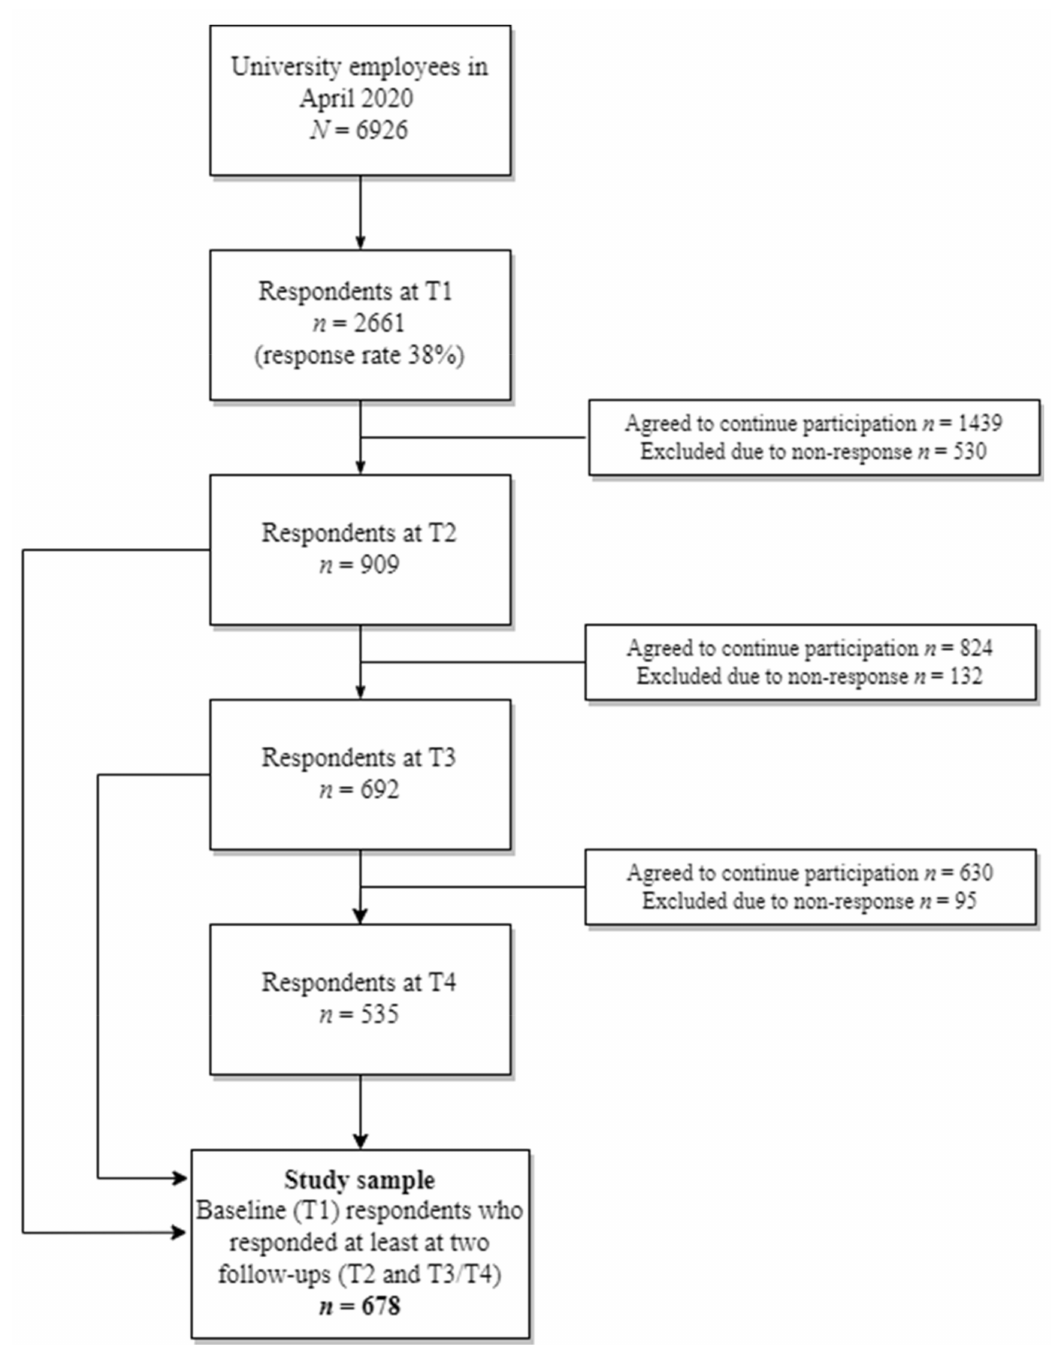
Figure 1. Flowchart of university employees included in the study of work ability profiles during COVID-19 lockdown. T1–T4 are data collection points: T1, April 2020; T2, June 2020; T3, October 2020; T4, March